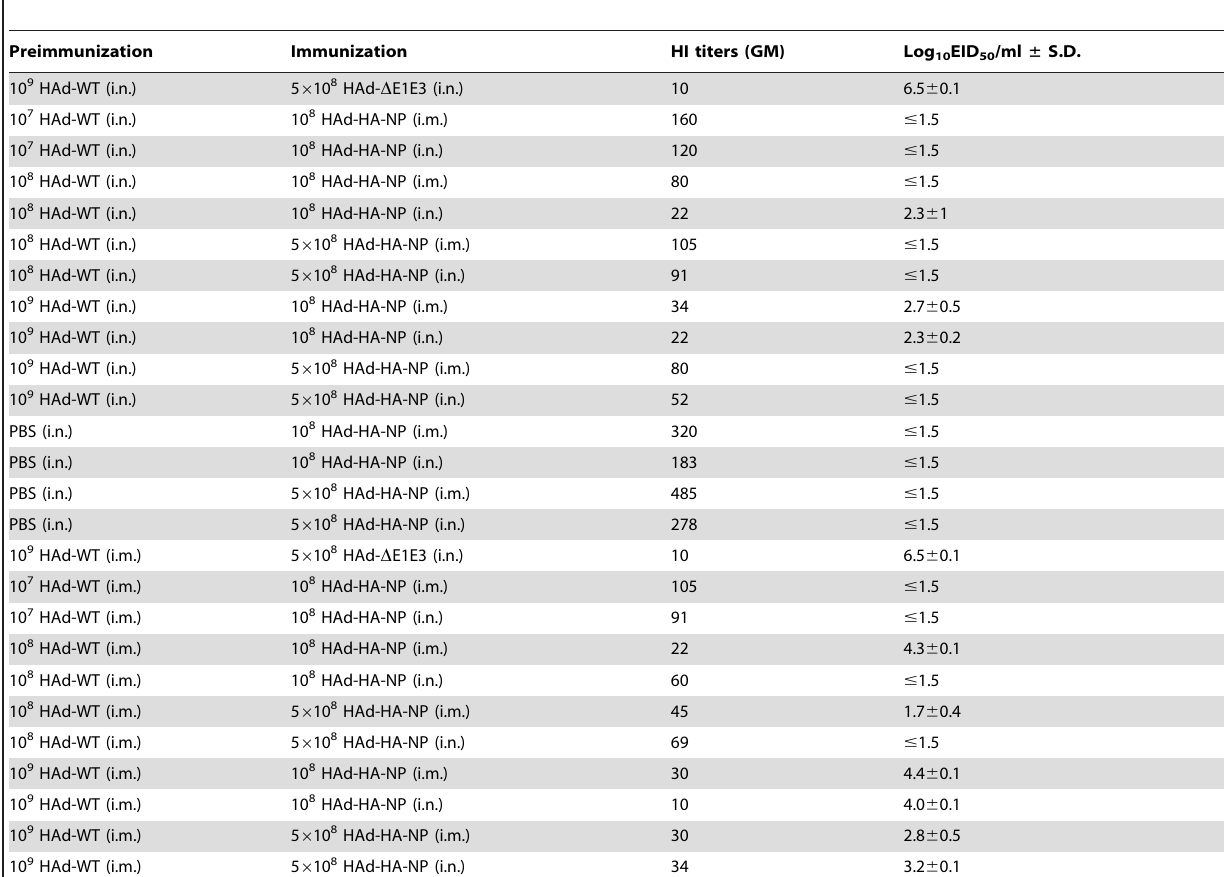
Table 1. Hemagglutination inhibition (HI) antibody titers before challenge and lung viral titers 3 days post-challenge with a homologous H5N1 reassortant virus in HAd-HA-NP-immunized naı¨ve and HAd-primed mice.